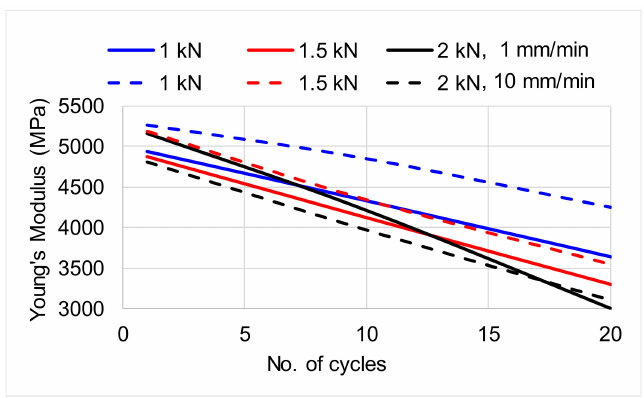
Figure 6. Degradation rate of Young’s Modulus with cyclic loading.